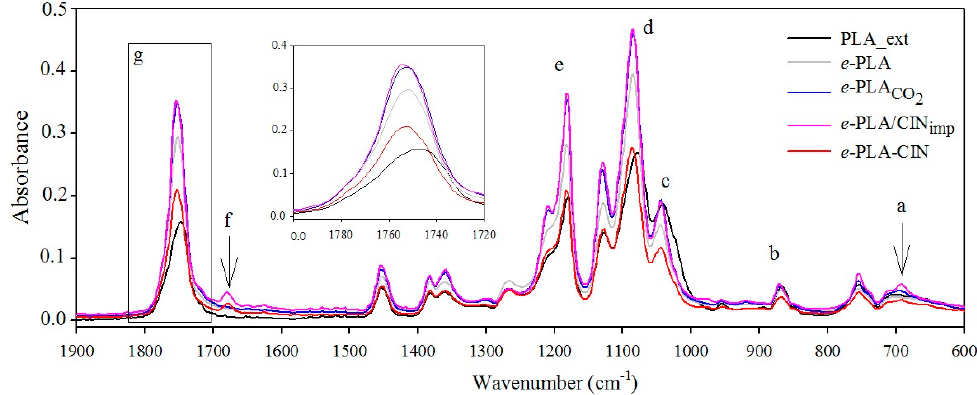
Figure 4. FTIR spectra of PLA materials: extruded PLA film ( black ); electrospun PLA mat, e- PLA ( grey ); electrospun PLA mat after scCO 2 impregnation conditions, e- PLA CO impregnated with CIN, e- PLA/CIN imp ( pink ); and electrospun PLA with CIN, e- PLA-CIN ( red ). Insert: Zoom at zone 1800–1720 cm − 1 of PLA-based materials.